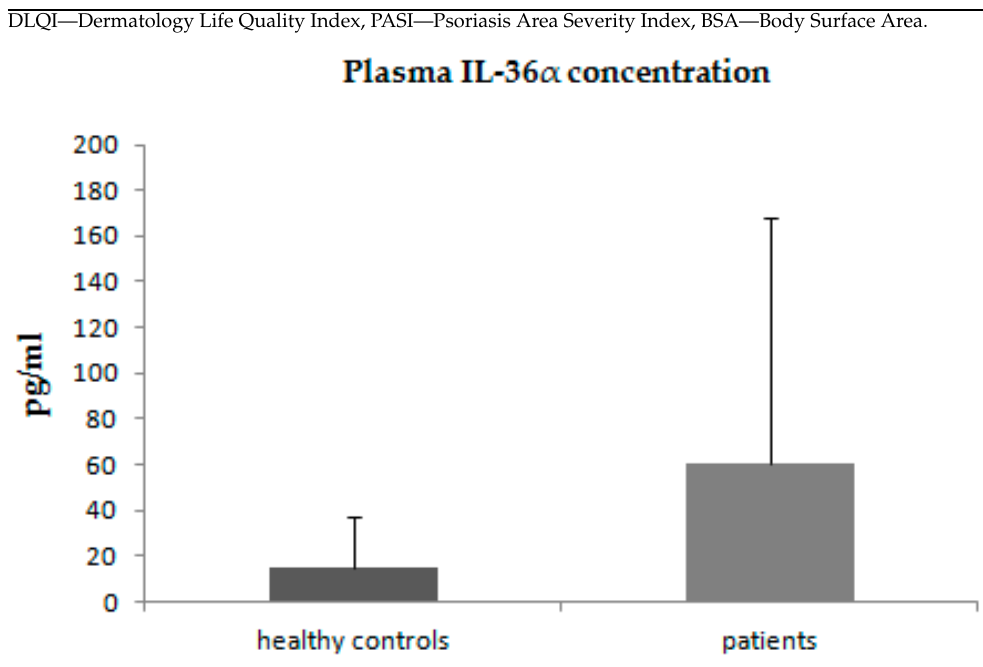
Figure 1. Plasma concentrations of IL-36 α in patients with psoriasis and control group. In patients with psoriasis, we observed statistically significantly decreased plasma concentrations of IL ‐ 36 β (Figure 2).